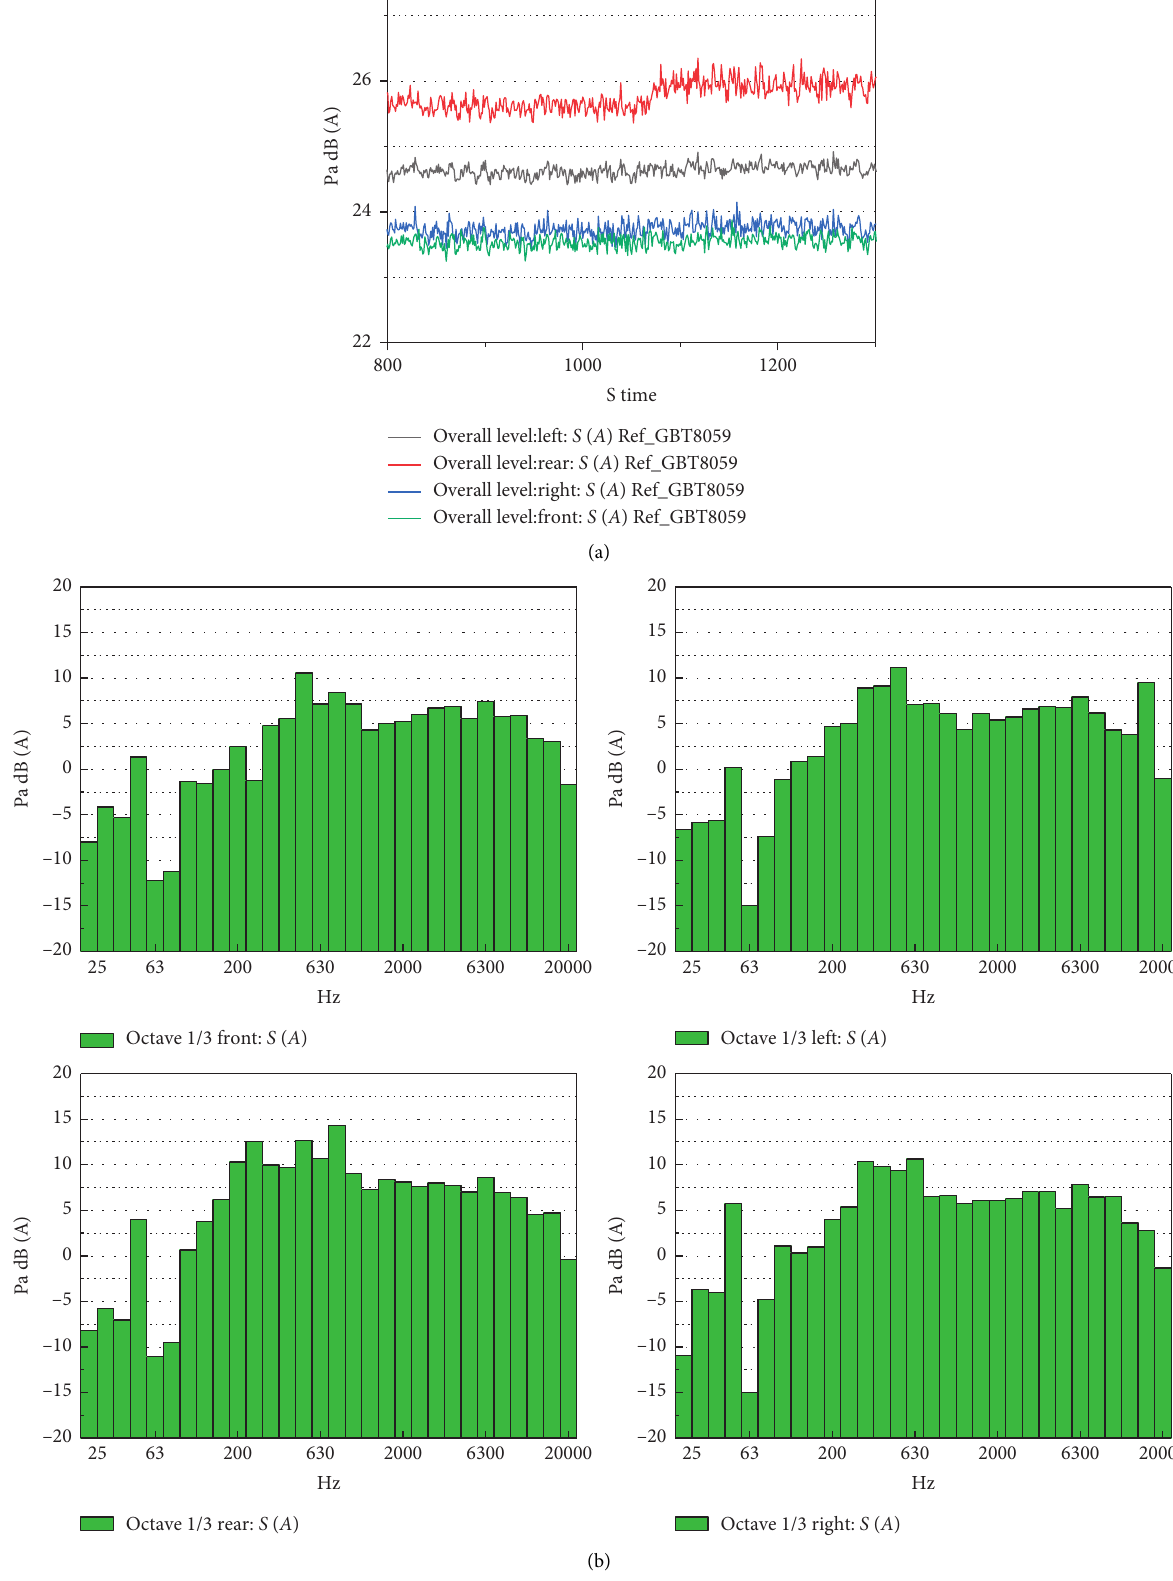
Figure 8: (a) Noise curves of running cycle of the freezer after improvement. (b) Noise spectrum distribution of running cycle of the refrigerator after